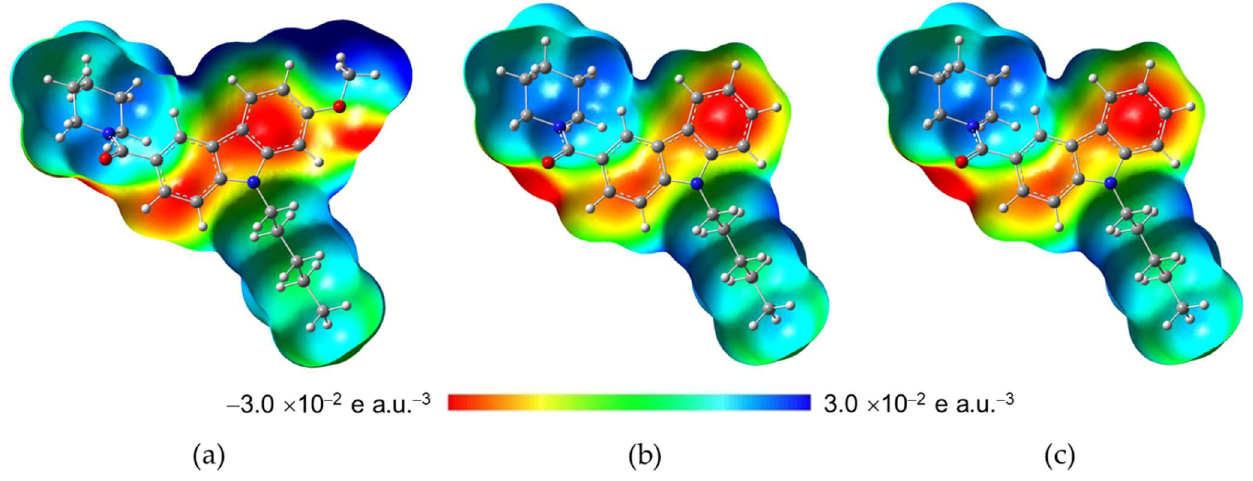
Figure 5. Molecular electrostatic potential maps. In: ( a ) NMP-4, ( b ) NMP-7, and ( c ) NMP-181 compounds at BP86/cc-pVTZ level of theory in chloroform.